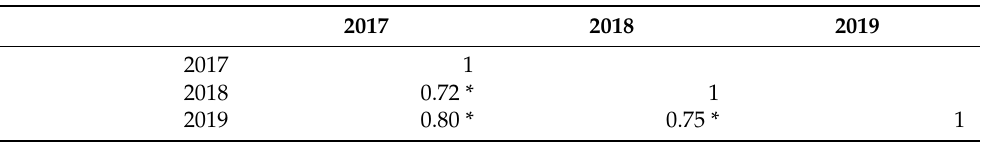
Table 2. Pierson’s correlation coefficients for pairwise comparison of phosphorus content in the starch of crops harvested in different